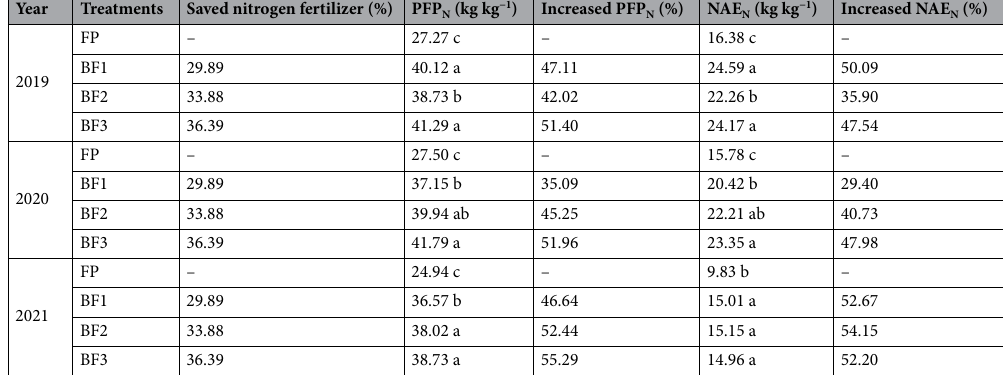
Table 2. Nitrogen use efficiency of wheat among the different treatments. FP and BF indicate farmer practice and balanced fertilization, respectively.